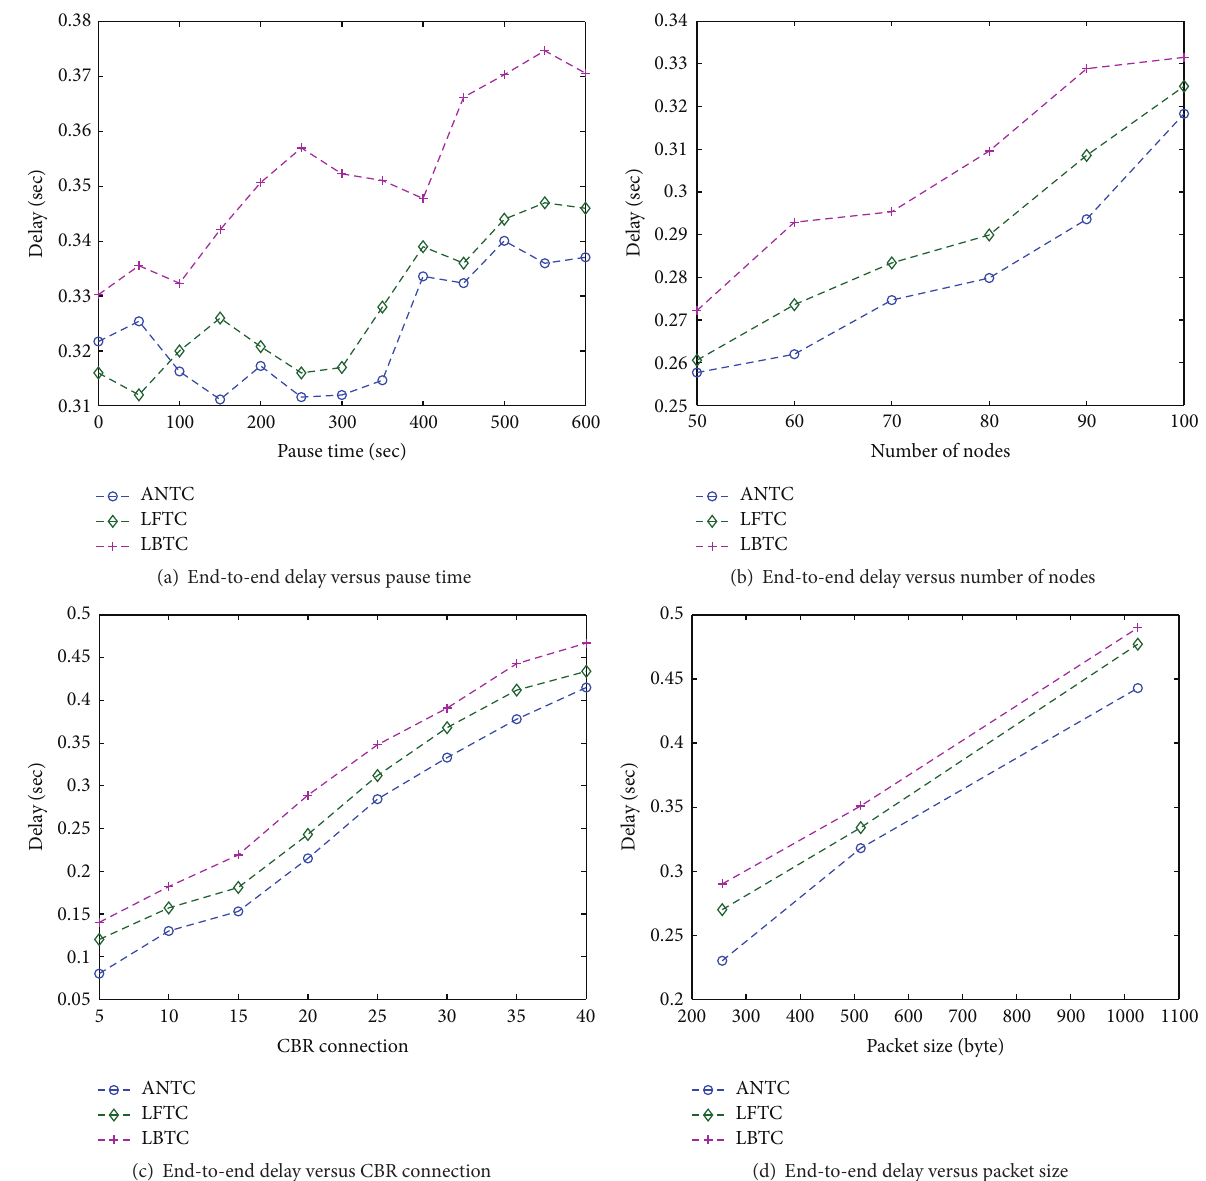
(d) End-to-end delay versus packet size Figure 8: End-to-end